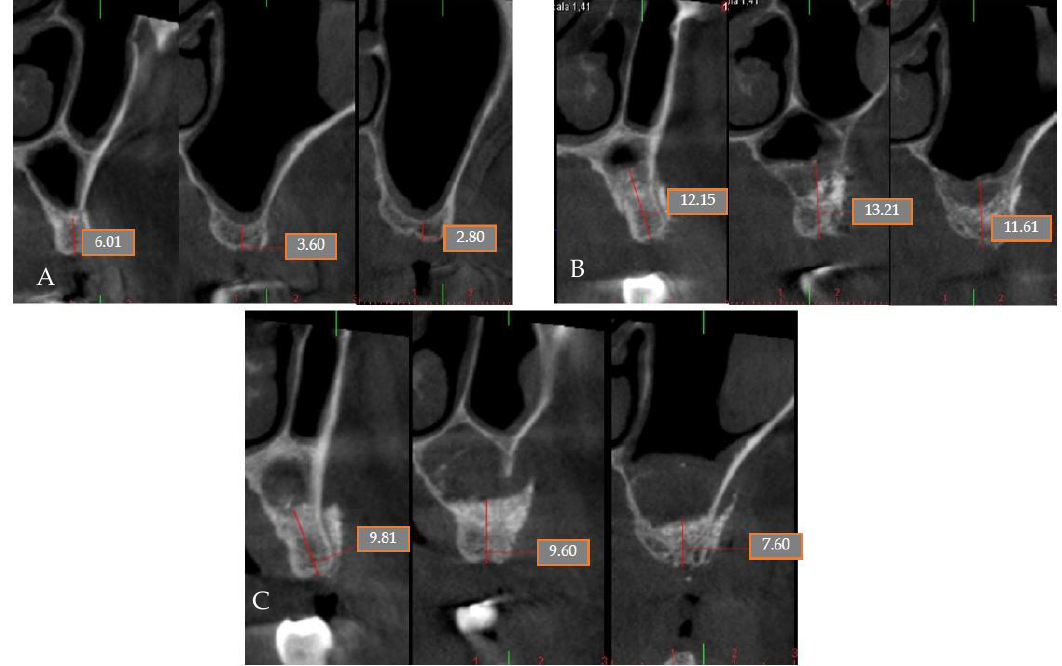
Figure 21. ( A ) Preoperative CBCT at level 24, 25, and 26; ( B ) Immediate postoperative CBCT at level 24, 25, and 26; ( C ) Postoperative CBCT after 4 months at level 24, 25, and 26.